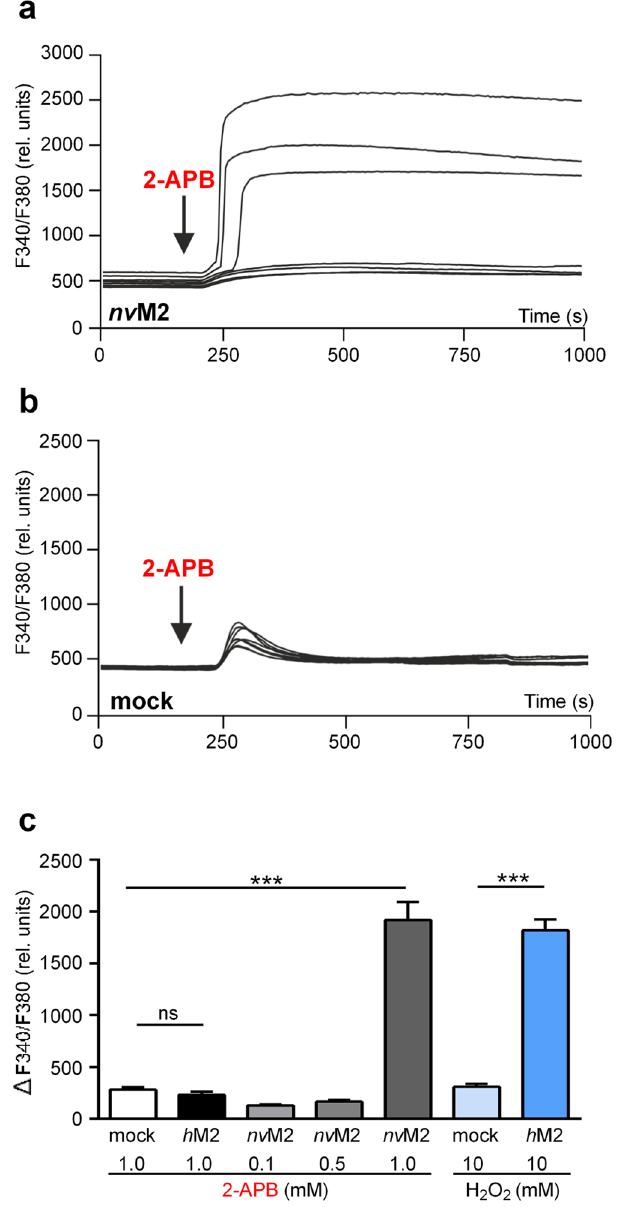
Figure 4. Ca 2 + entry through nv TRPM2 induced by 2-APB in calcium-imaging experiments. ( a ) Representative traces from cells that either did or did not express nv TRPM2 after application of 2-APB (1 mM) to the bath. ( b ) Traces from some mock-transfected cells that showed the highest levels of responses that cannot be attributed to 2-APB. ( c ) 2-APB induced Ca 2 + entry occurs exclusively in cells transfected with nv TRPM2 and requires 1 mM 2-APB. Left: Comparison of nv TRPM2-transfected cells with mock-transfected and h TRPM2- transfected cells (summary). Right: Stimulation of h TRPM2 (in the absence of 2-APB) was still possible with H 2 O 2 (10 mM), demonstrating the functional expression of the channel. Note that the increase of [Ca 2 + ] i induced by 2-APB in nv TRPM2 is comparable to that of H 2 O 2 in h TRPM2. Asterisks indicates significant differences ( *** P < 0.001; Student’s t-test, n = 5–15). Error bars are